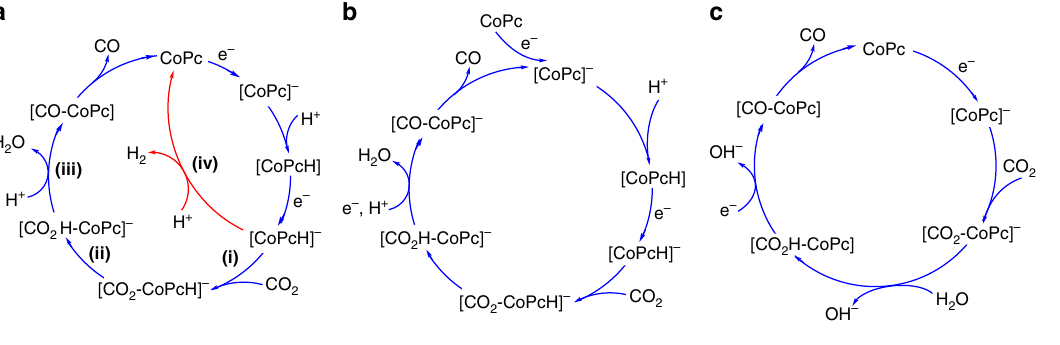
Fig. 3 Proposed CO 2 reduction mechanisms of CoPc in this work and other proposed mechanisms. a A proposed mechanism for CO 2 reduction by CoPc showing pathway for competitive H 2 generation 20 – 22 . Note that we do not assign individual oxidation states to the Co center and instead refer to the overall charge on the entire complex. Reported molecular orbital calculations of CoPc suggest that the fi rst reduction may be a metal-centered reduction of Co II Pc to Co I Pc followed by a second ligand-based reduction 41 . Other proposed CO 2 reduction by CoPc in b , organic solutions 20 and c , low concentration bicarbonate buffer in aqueous solution